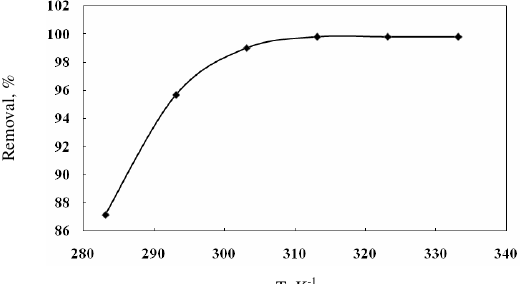
Figure 7 . Effect of temperature on removal of CR at 0.025g of PtN-AC in 50 mL, pH 4 and dye concentration of 15 mg L